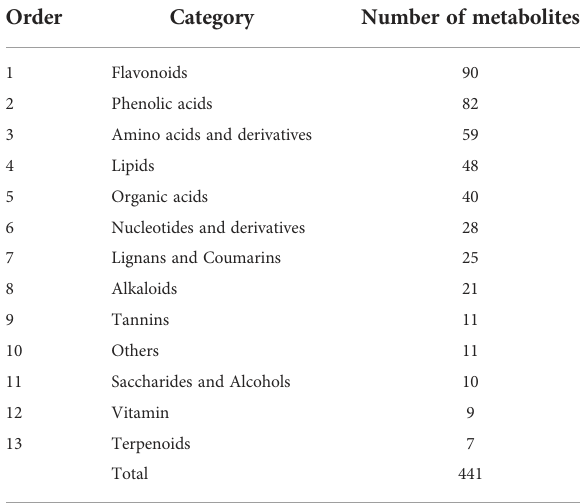
TABLE 1 Categories of the 441 DAMs between EC and NEC of L. kaempferi .